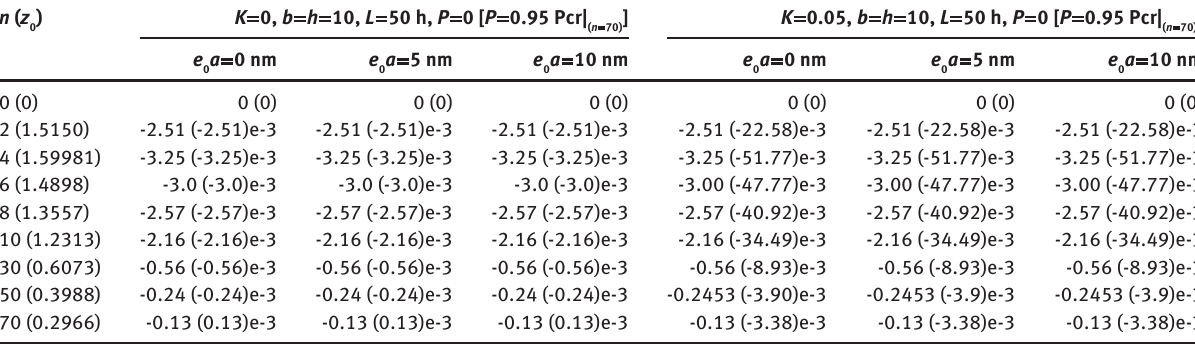
Table 3: Percentage of computational error due to lack of consideration of the precise location of the neutral axis in FG nanobeams. ) n ( z 0